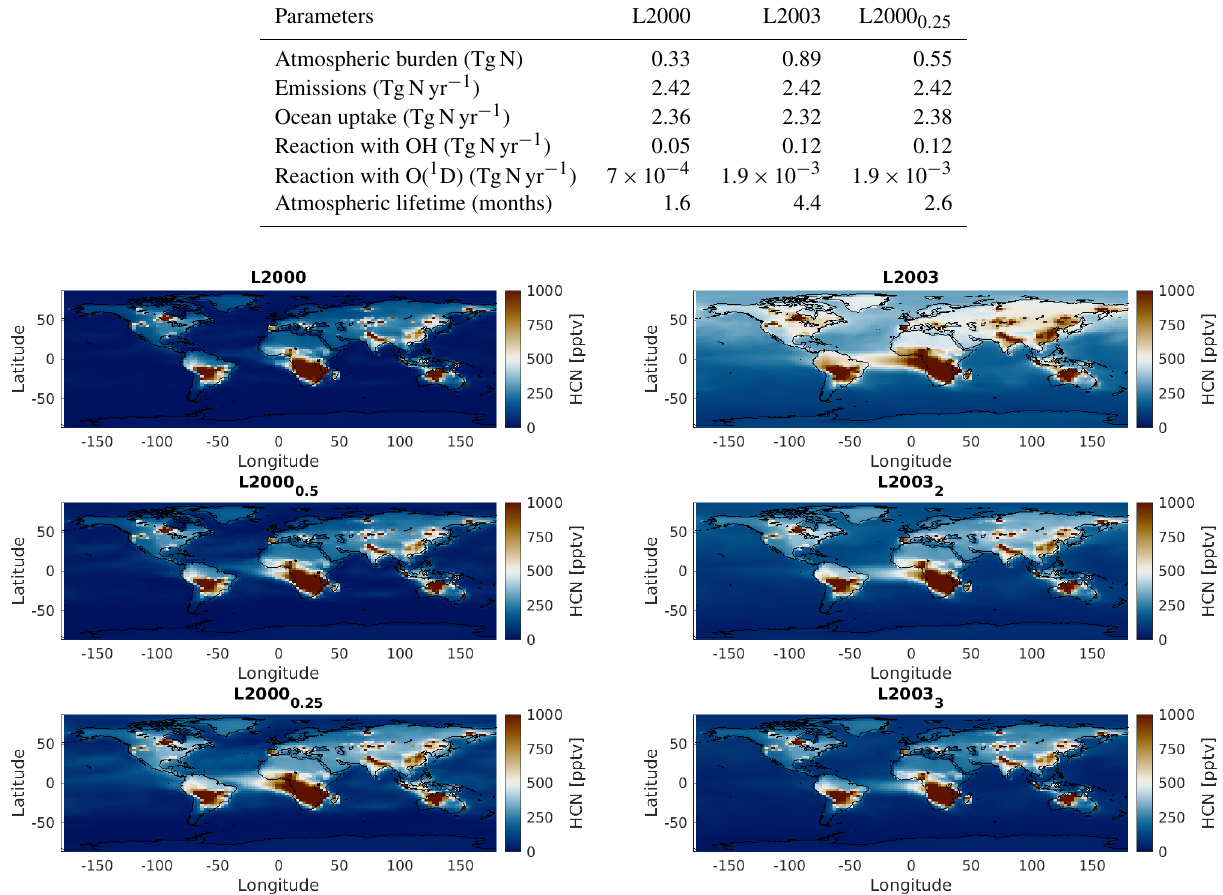
Figure 5. Simulated global distributions of HCN (pptv) for six model tracers, L2000–L2003 3 , at the surface level for September